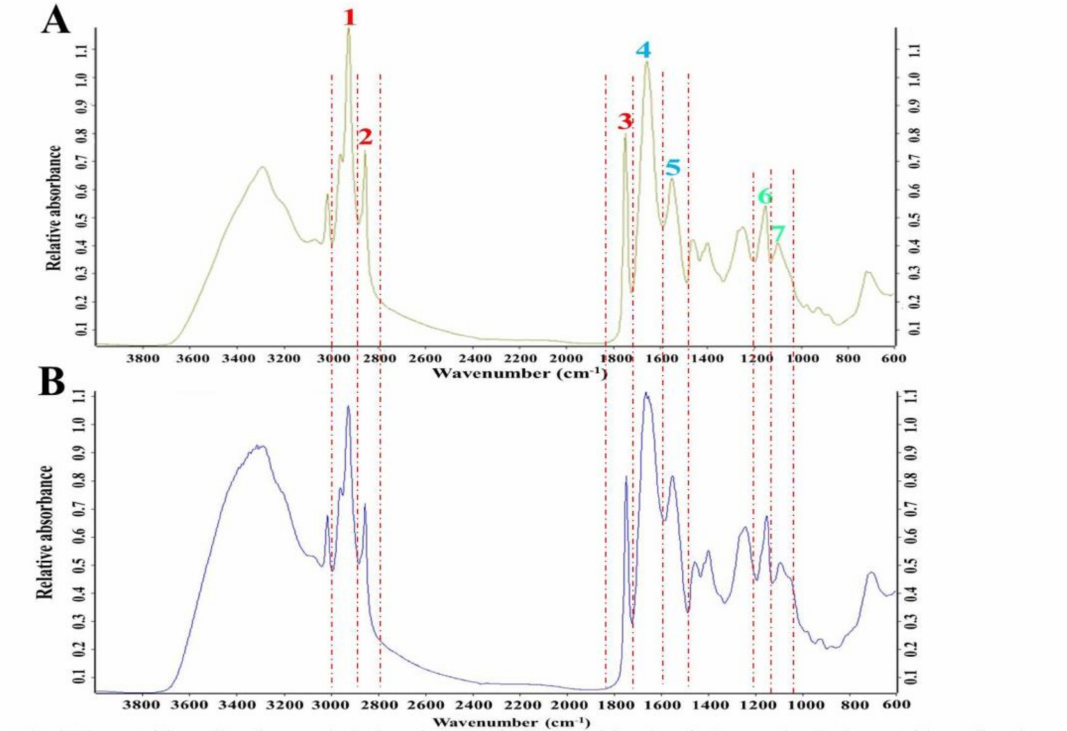
Figure 1. The profile of FT-IR absorption peaks for the H 2 O-treated Aurantiochytrium sp. cell ( A ) and the D 2 O-treated Aurantiochytrium sp. cell ( B